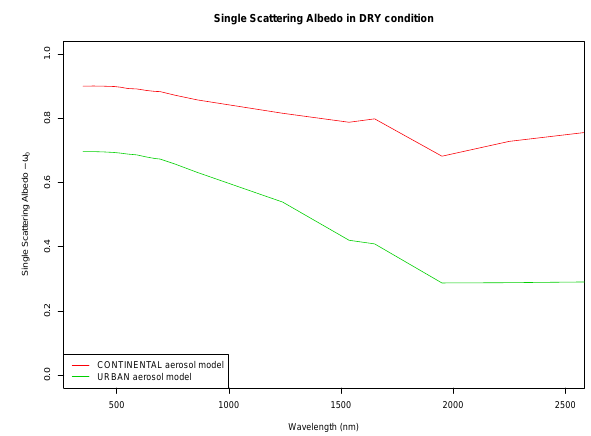
Fig. 1. Single scattering albedo ( ω 0 ) of continental and urban aerosol model, available in dry condition from the 6SV1.1 code.